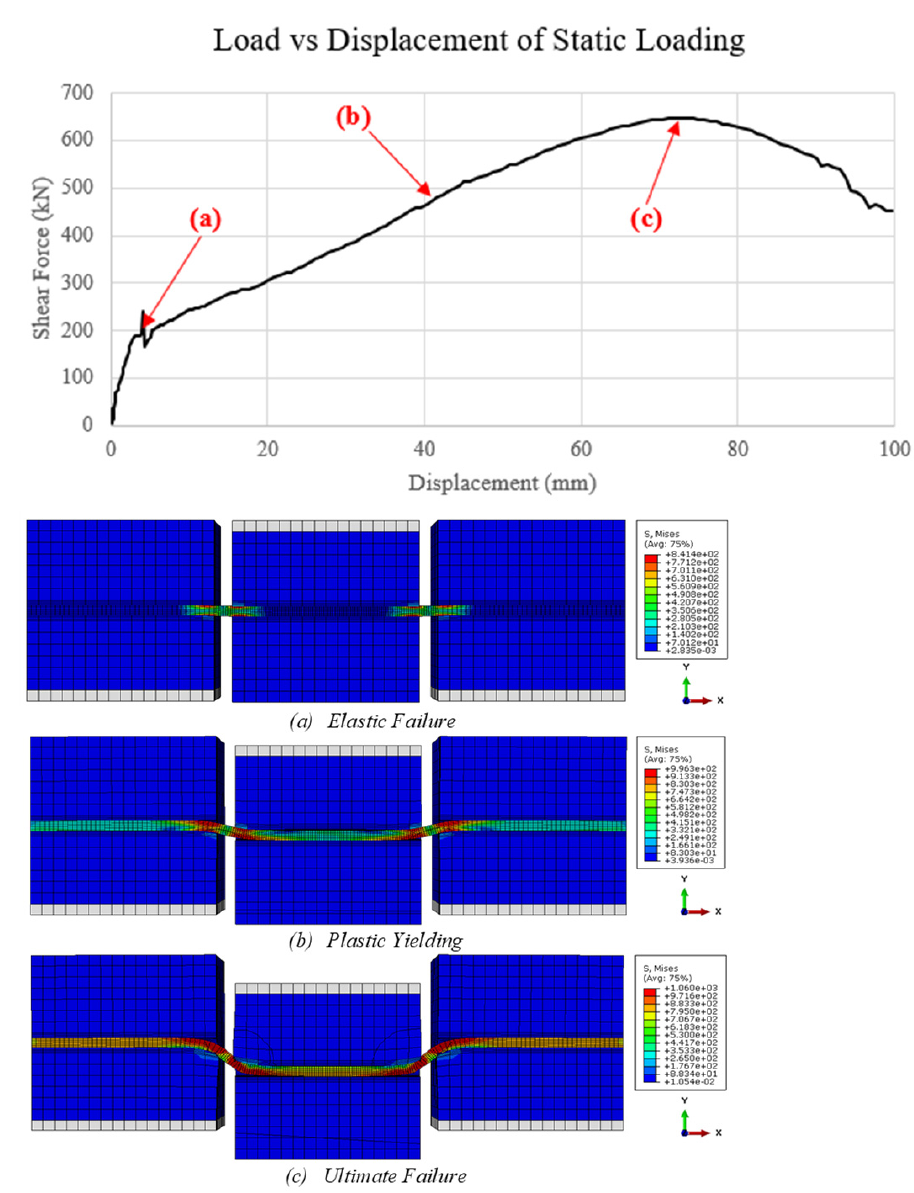
Figure 24. Stages of shear failure under static loading conditions.